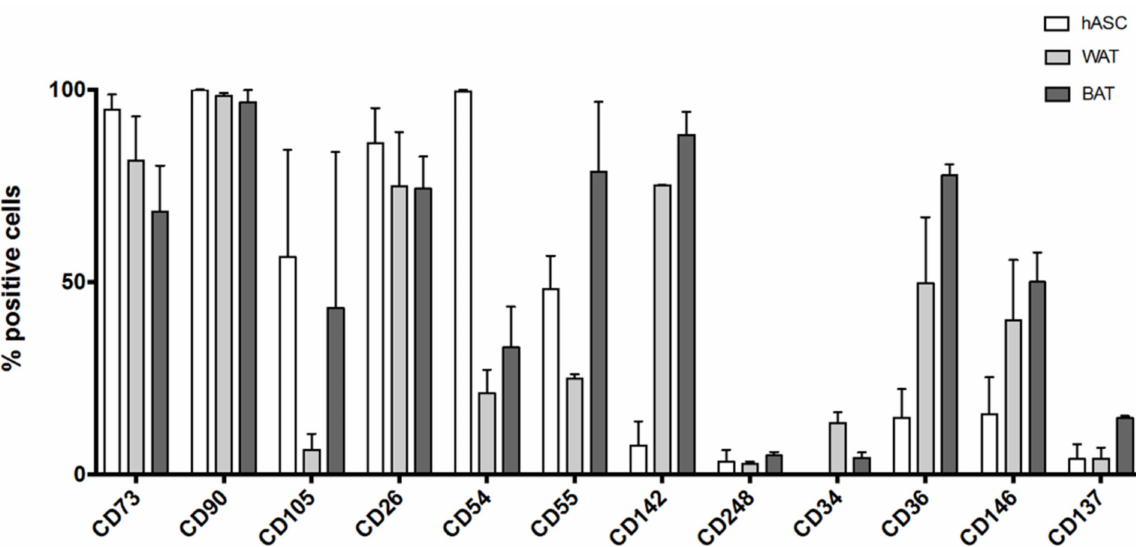
Figure 10. Percentages of cells found to be positive for the 13 surface markers chosen for this analysis. Bar chart of summarized flow cytometry data for hASCs cultured in UrSuppe basal medium (white bar) or for cells differentiated in either US-WAT (grey bar) or US-BAT (black bar) medium. The chart shows the mean percentage of positive cells for the indicated surface markers. Average of data obtained from three different donors (n = 3, error bars represent